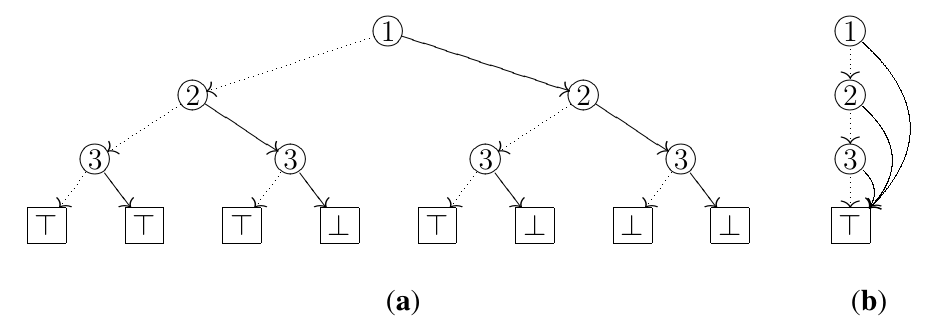
Figure 1. The two graph representations for the same set family {∅ ; { e ( a ) Binary Decision Tree; ( b )